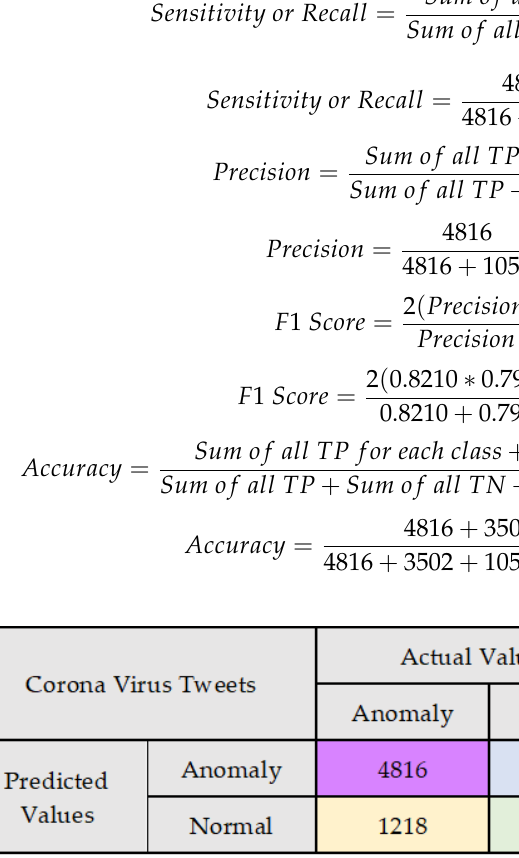
Figure 6. Confusion matrix of case study—Corona Virus Tweet Dataset.